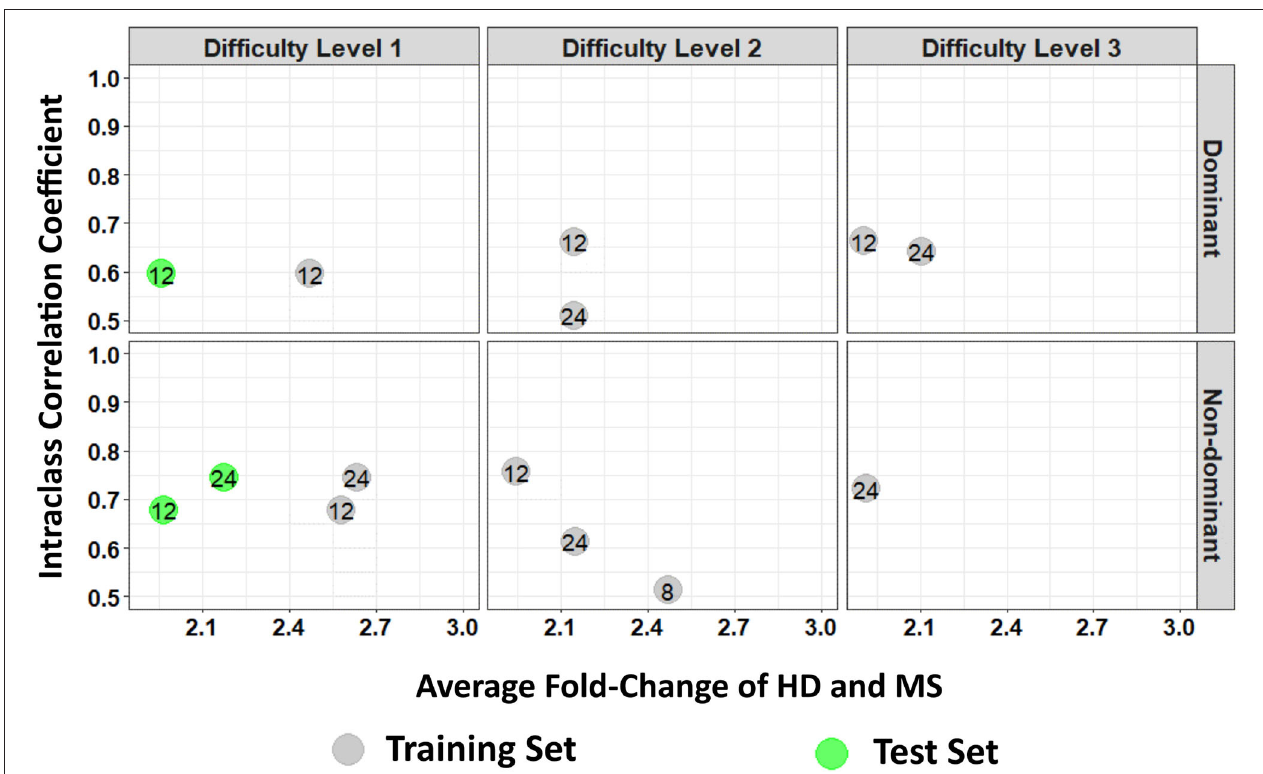
FIGURE 3 | Average fold change (FC) of HD and MS of the spiral-derived features with respect to their Intraclass Correlation Coefficient (ICC) where ICC was calculated from the granular data of the patients with MS. The numbers indicate the feature’s labels as illustrated by the label in Table 2 . Gray colors are features from the training set while green colors are the test set. Here we only include FC > 2 and ICC > 0.5. A diagram of all features that are statistically significant between HD and MS in the training and test set for patients with MS ICC is provided as Supplementary Figures S7, S8 , respectively, in the Supplementary Material (HD and MS indicate healthy donors and multiple sclerosis patients,